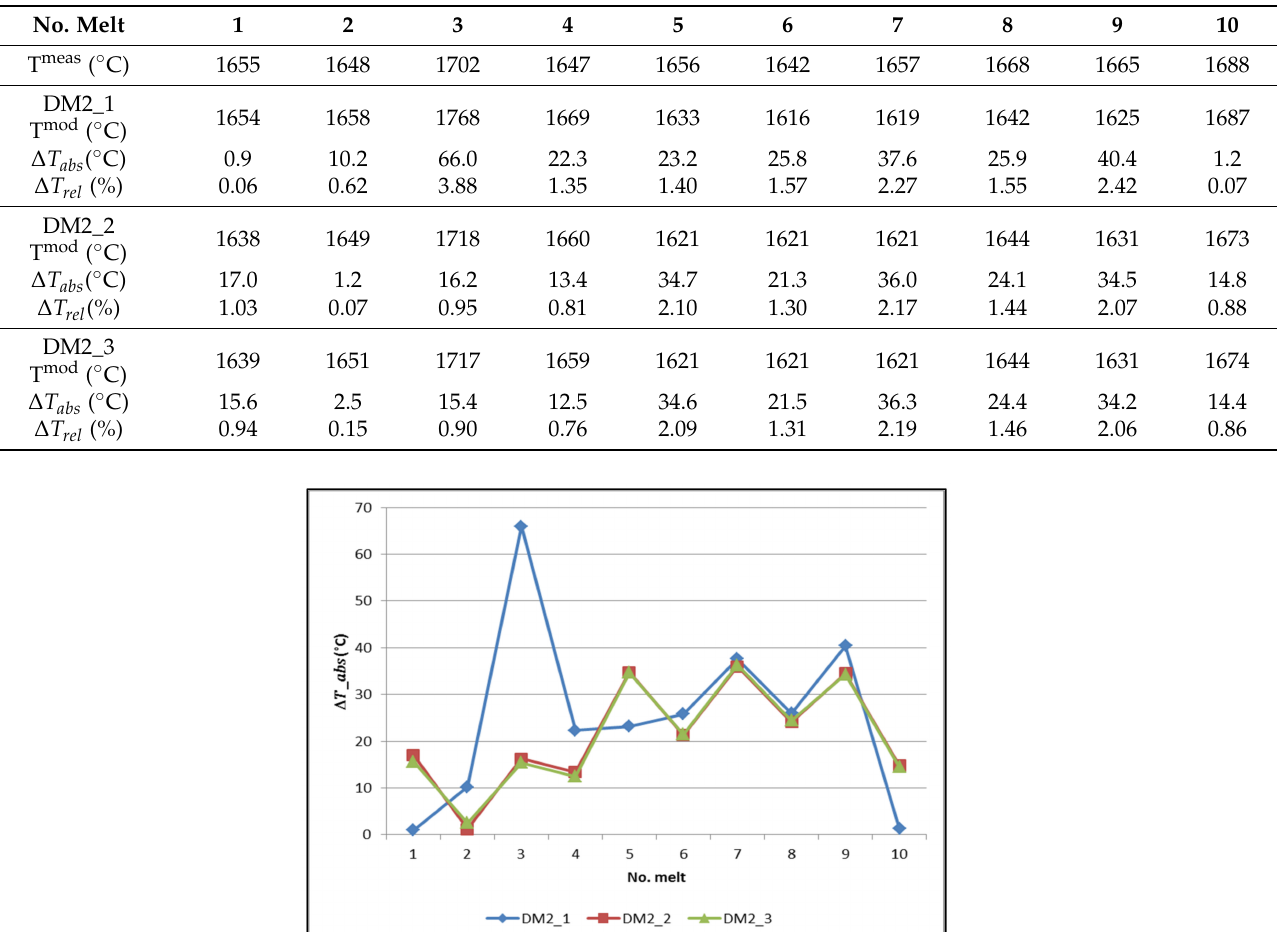
Table 3. The results of the deterministic model without feedback.